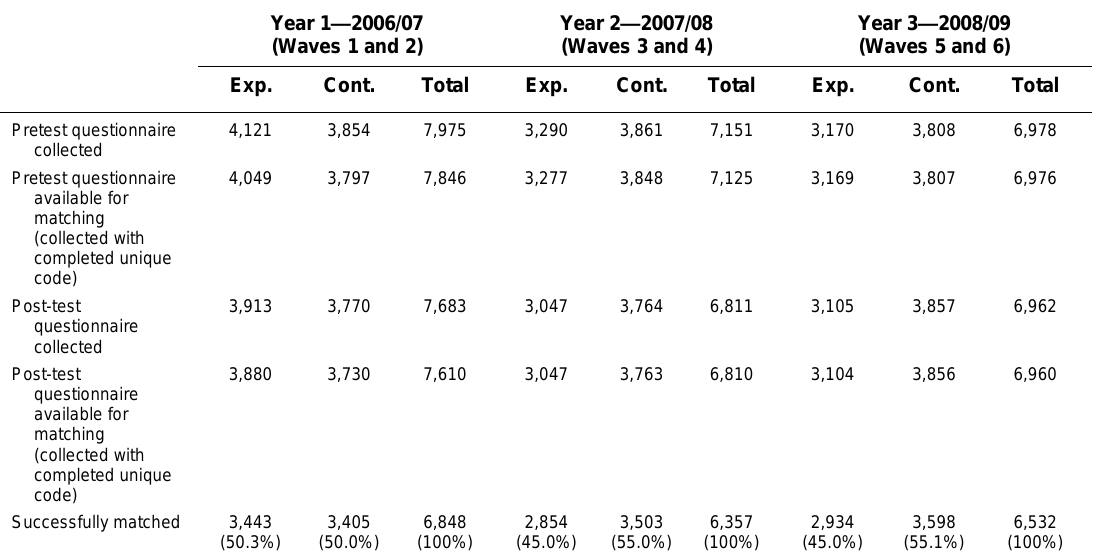
Number of Participants and Completed Questionnaires Collected Across 3